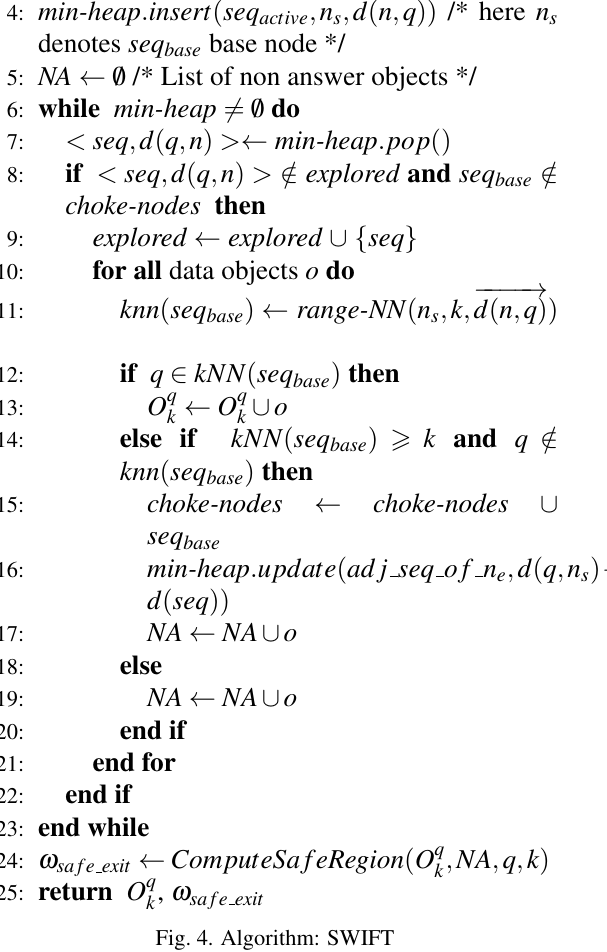
Fig. 4 present details of the SWIFT algorithm